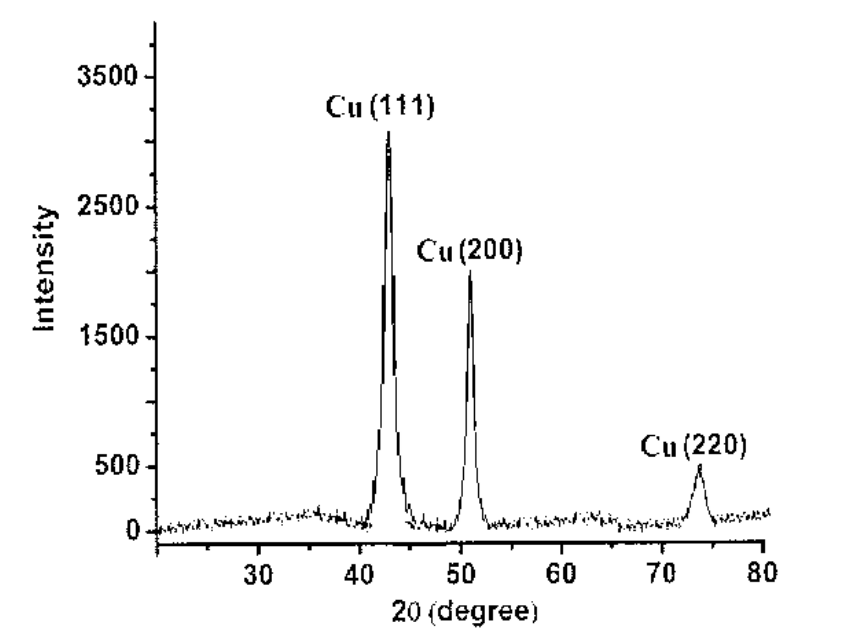
Figure 3. XRD pattern of the TA-mediated CuNPs.